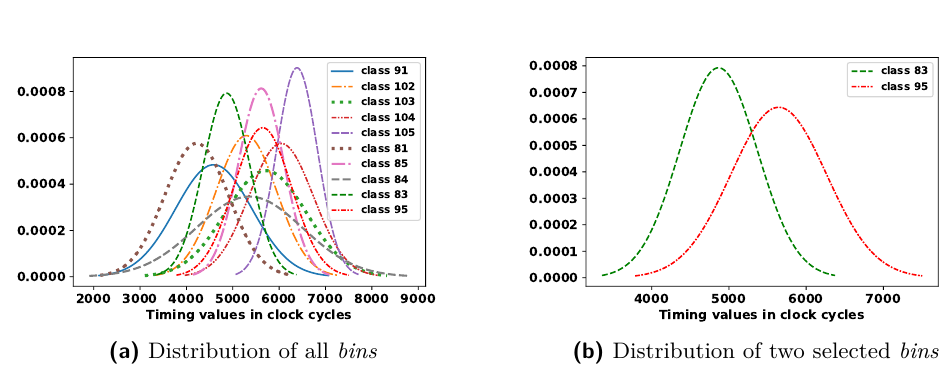
Figure 5: Template formation phase: Distribution of timing observed using RASSLE for (10 m + n ) classes where m = no. of subtraction and n = no. of